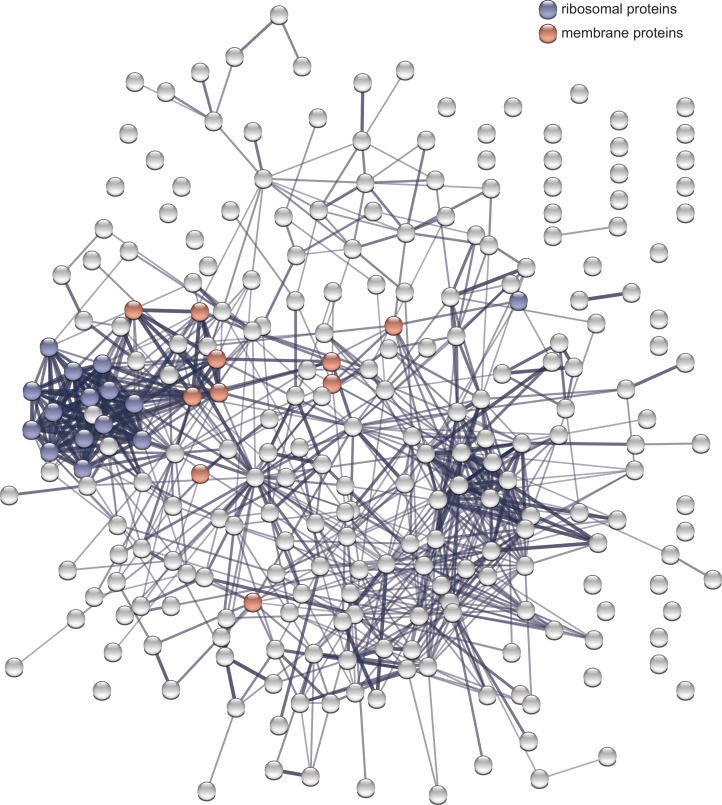
STRING interaction network of the proteins that accumulated in the Cpa-knockout strain during carbon starvation.The blue circles represent ribosomal proteins and the red circles correspond to membrane proteins. The entire network represents proteins identified by LFQ-MS as having increased levels in the cpa-knockout strain under carbon limitation. Edge thickness of lines between the protein nodes corresponds to interaction confidence, according to STRING confidence scores.